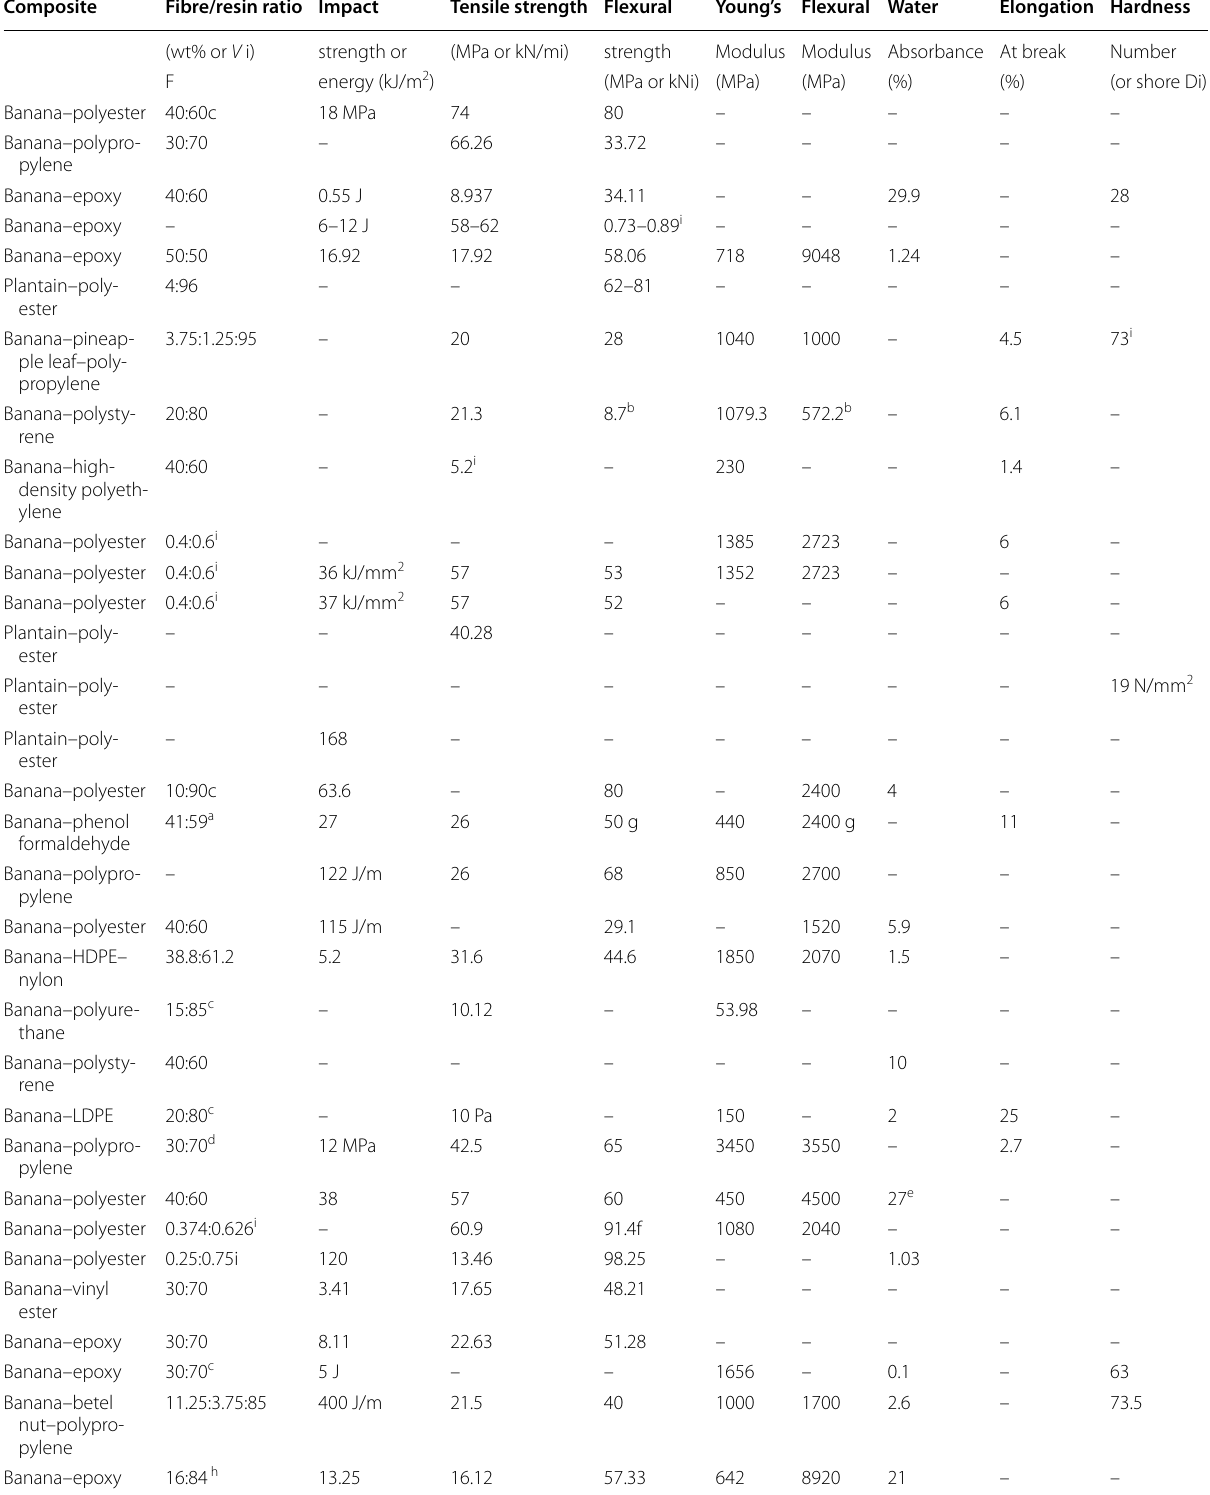
Table 5 Summary of the physicomechanical properties of Musa spp. fibre composites (Kulkarni et al. 2019) Composite Fibre/resin ratio